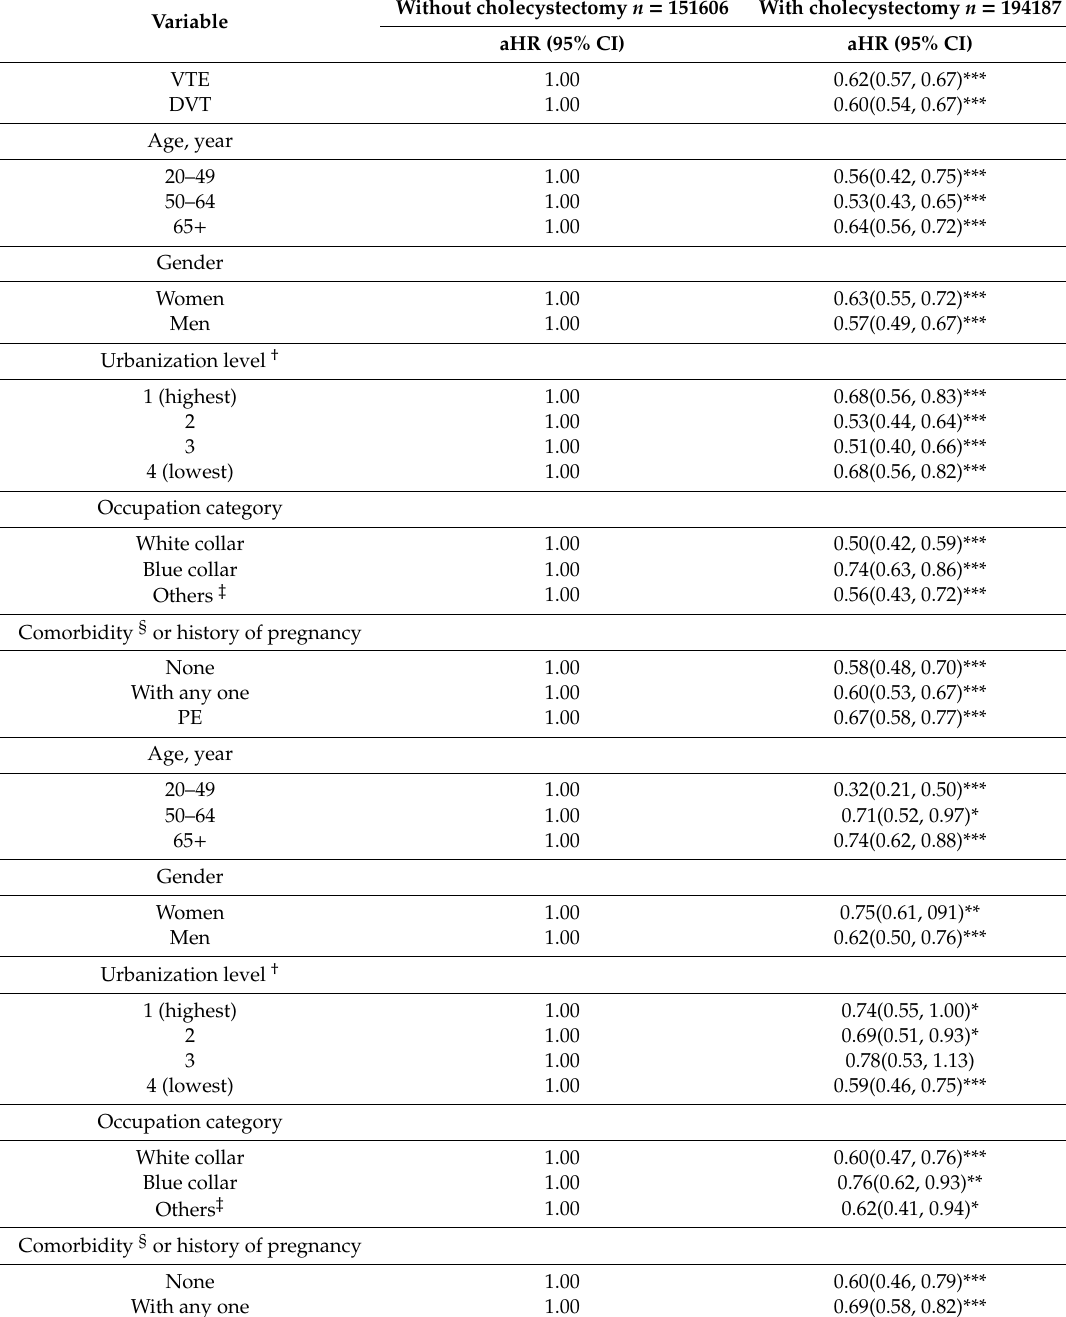
Table 3. Incidence and hazard ratio of VTE, including DVT and PE, between patients with and without gallstones based on the stratification of demographic characteristics and the presence or absence of a comorbidity or history of